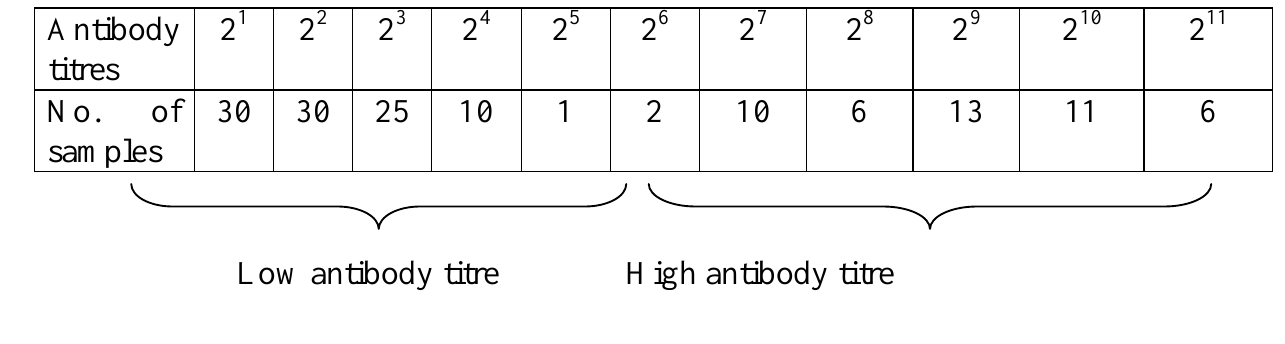
Table (5): a- Result of antibody titres to NDv vaccines in chicken having high level of parasitic infection Antibody